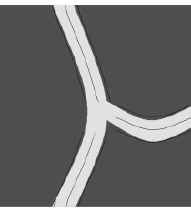
Figure 4: Initial snake and detected roads in a synthetic image